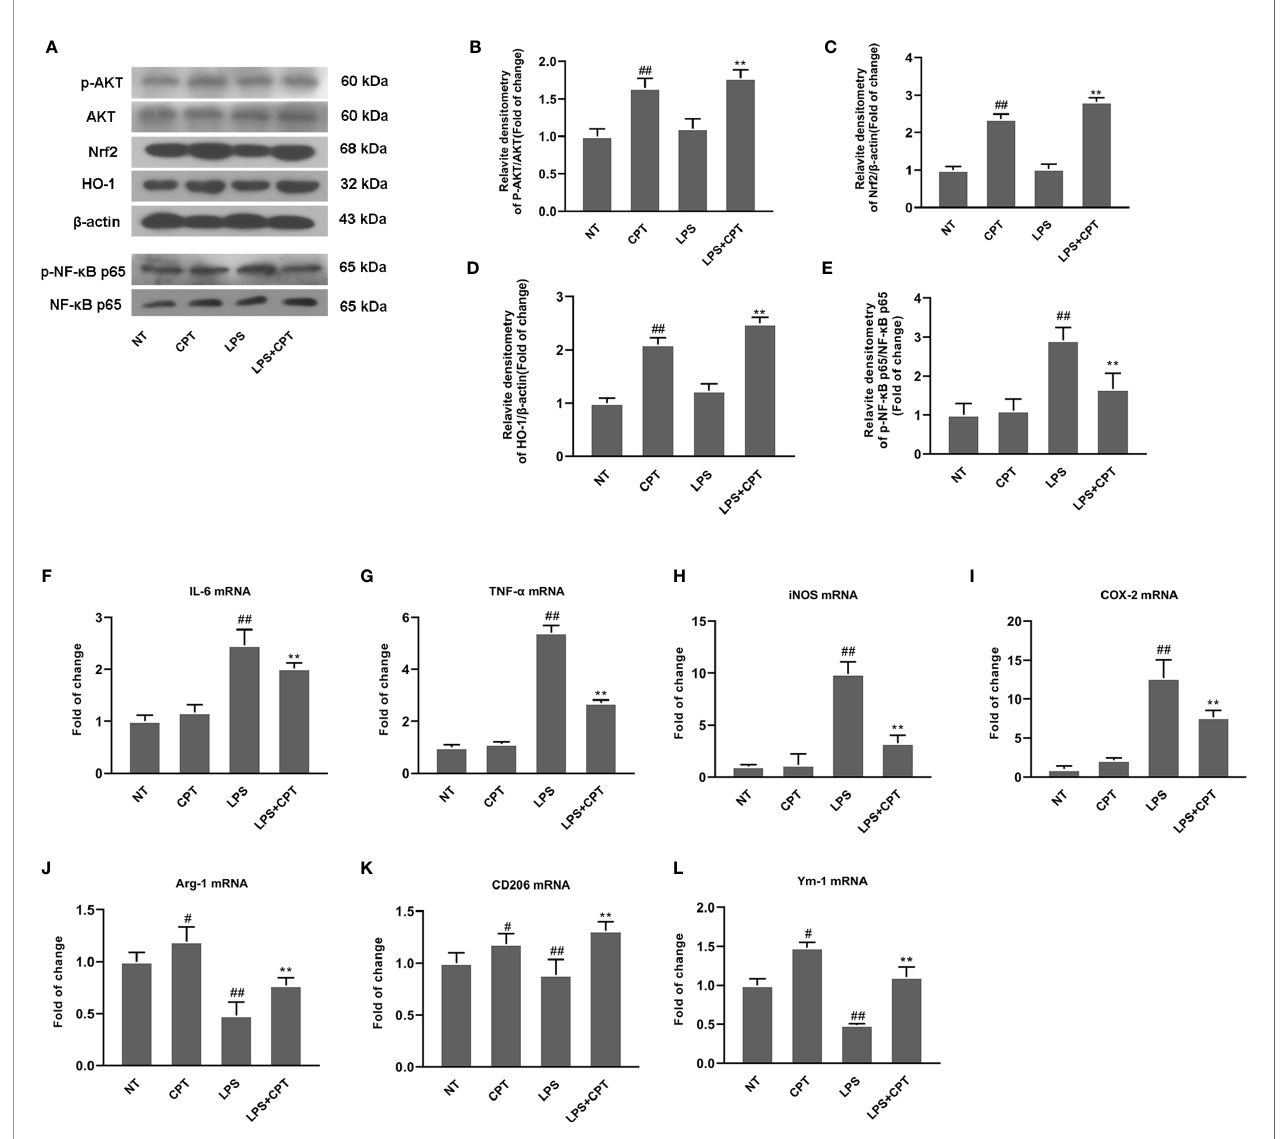
FIGURE 3 | CPT treatment inhibits in fl ammatory response and regulates microglia polarization in LPS- injected PD mice. On the 28th day after modeling, the midbrain of mice was peeled off and ground. (A – E) AKT/Nrf2/HO-1 and NF- k B signal pathways were detected using western blot. (F – L) The mRNA levels of M1 markers (IL-6, COX-2, iNOS, and TNF- a ) and M2 markers (Ym-1, CD206, and Arg-1) were detected using RT-PCR. Results are shown as means ± SD (n= 5). ## p < 0.01 vs. the no-treatment (NT) group; **p < 0.01 vs. the LPS-exposed group. ## p < 0.01 vs. the no-treatment (NT) group corrected to # P < 0.05 and ## P < 0.01 vs. the no-treatment (NT)